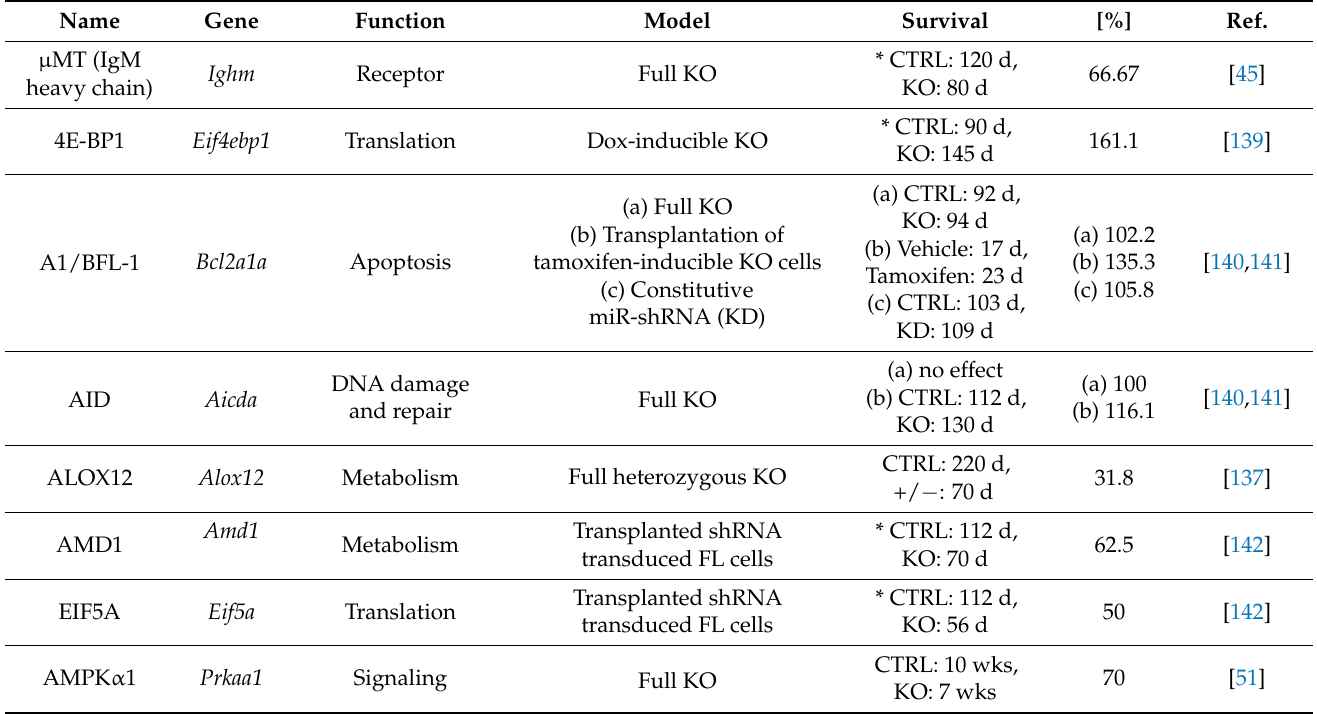
Table 1. List of all mouse models analyzed combined with the E µ -Myc transgene and their respec- tive